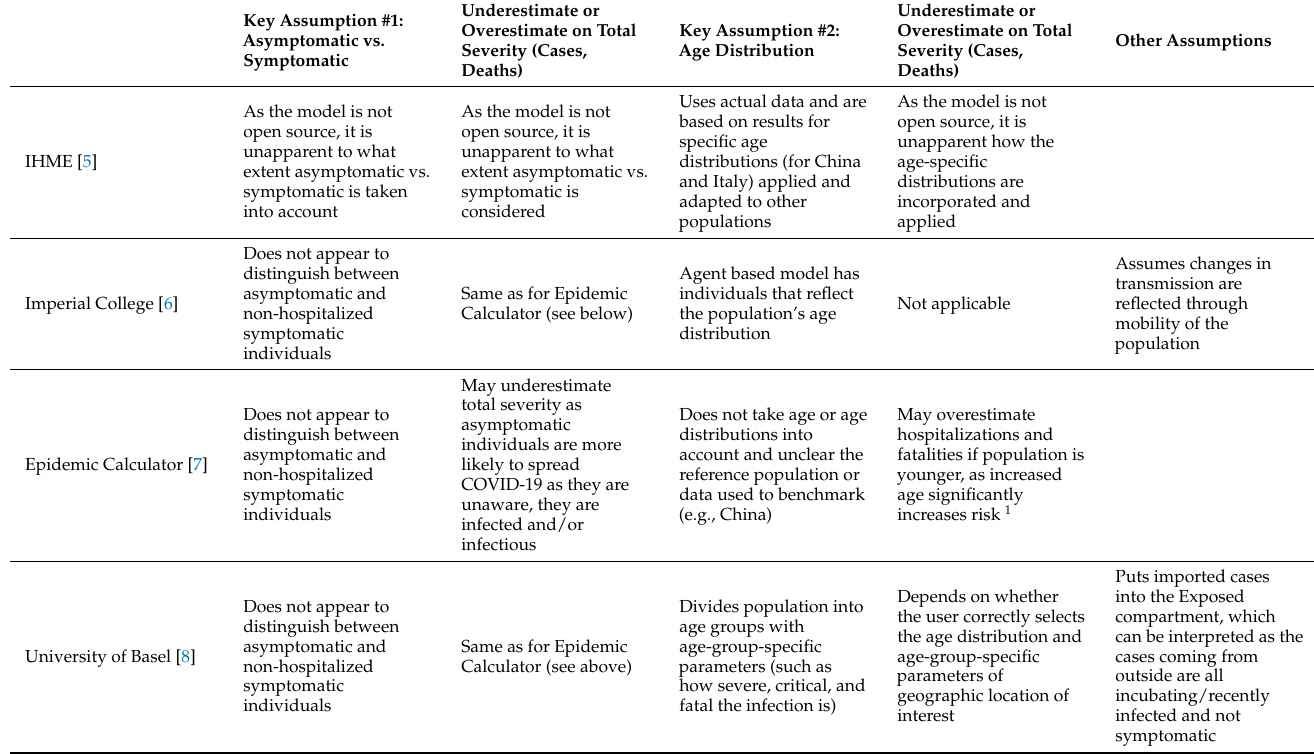
Table 2. Selected model assumptions for informing COVID-19 control and mitigation,